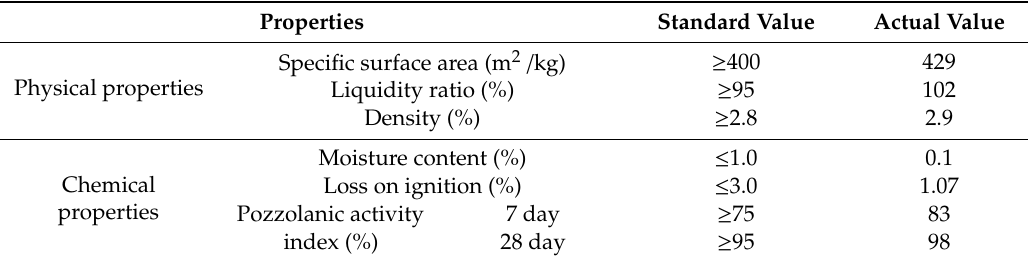
Table 4. Physical and chemical properties of mineral powder.